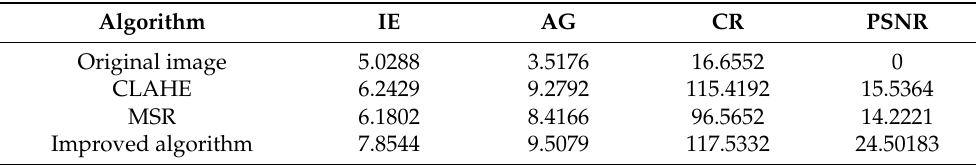
Table 6. Evaluation criteria of various algorithms for processing scratch defect